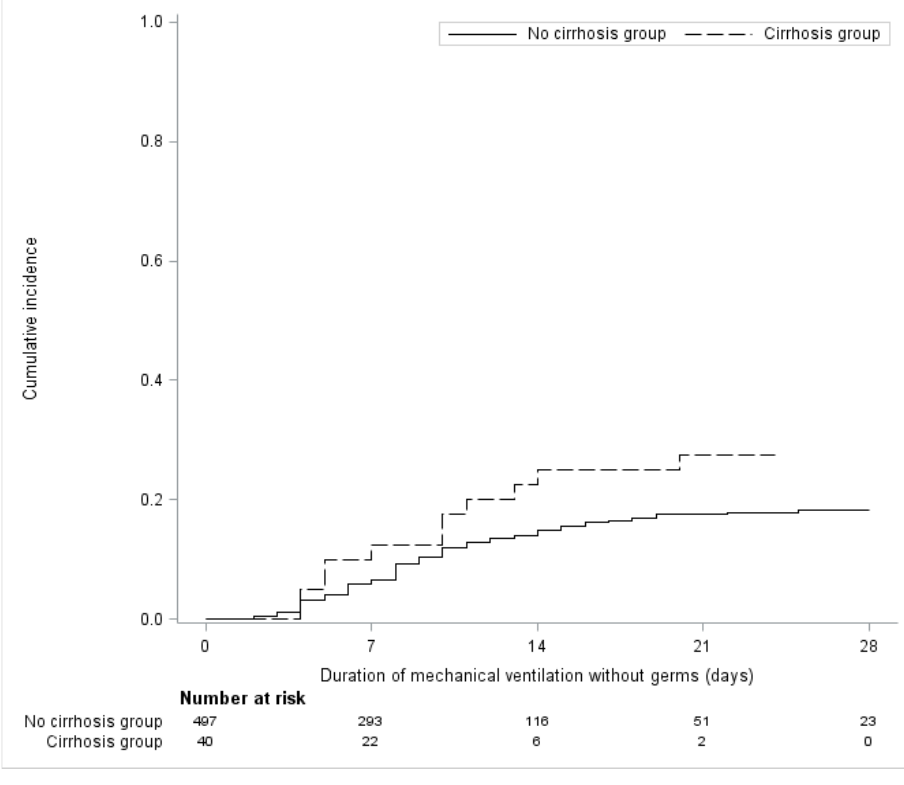
Figure 2. Cumulative incidence of VAP in patients with and without cirrhosis, after matching.